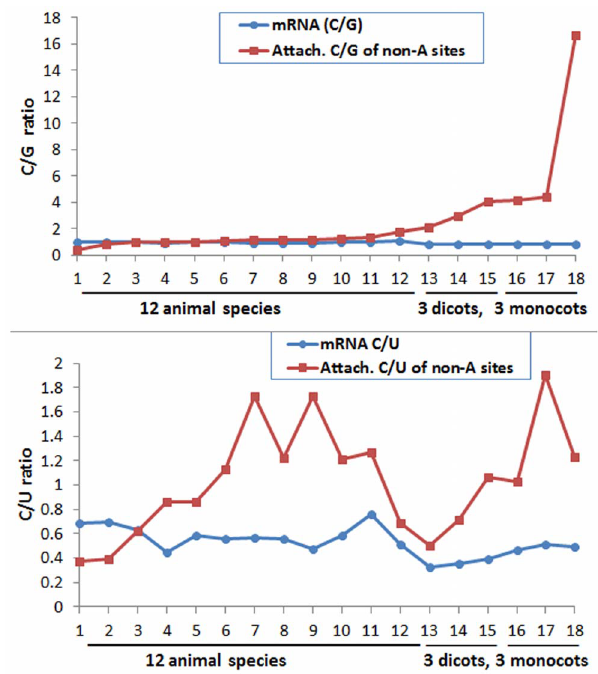
Figure 3. The C/G and C/U ratios at the polyadenylation [poly(A)] tail attachment position of non-A-type poly(A) transcripts. The 18 species, namely 12 animals, 3 dicot plants, and 3 monocot plants (3 cereals: rice, maize, and sorghum), were sorted from smallest (1) to largest (18) by the C/G ratios at the poly(A) tail attachment position of non-A-type poly(A) sites. The order of animal species from 1 to 12 is dog, rabbit, rat, zebrafish, mouse, cattle, zebra finch, orangutan, chicken, human, pig, and fruit fly. The three dicot plants are, in order, Medicago truncatula , Arabidopsis thaliana , and poplar. The three monocot plants are, in order, rice, maize, and sorghum. A: Comparison between the poly(A) tail attachment position C/G ratio and the messenger RNA (mRNA) C/G ratio. The mRNA C/G ratio is from the 99–nucleotide upstream region starting from, but not included, the poly(A) tail attachment position. There was an overall negative correlation between the poly(A) tail attachment nucleotide C/ G ratio and the mRNA C/G ratio ( r = 2 0.53, P , 0.05). Note that in animals, the poly(A) tail attachment position C/G ratio (1.05 on average) on non-A-type poly(A) sites was only slightly (1.08 times) greater than the mRNA C/G ratio (0.97 on average). In plants, however, the poly(A) tail attachment nucleotide C/G ratio (5.73 on average) was about sevenfold higher than the mRNA C/G ratio (0.83 on average), suggesting that plants strongly selected C over G as the poly(A) tail attachment nucleotide. B: Comparison between the poly(A) tail attachment position C/U ratio of non-A-type poly(A) sites and the messenger RNA (mRNA) C/U ratio. The 18 species were sorted from smallest ( # 1) to largest ( # 18) by the C/G ratios at the poly(A) tail attachment position of non-A-type poly(A) sites, as in the top panel. Note that the C/U ratio of the poly(A) tail attachment position of non-A- type poly(A) sites was greater than the messenger RNA C/U ratio in most species and the results suggest a selection of C over U at the poly(A) tail attachment position. doi:10.1371/journal.pone.0079511.g003 plants ( Table 3 ). Plants had lower adenosine content than animals did in this mRNA region. There was no significant correlation ( r =0.09) between the mRNA adenosine content and the adenosine percentage at the cleavage nucleotide replaced by the poly(A) tail ( Table 3 ). These results demonstrate that poly(A) site selection is not a simple, random reflection of the genomic nucleotide composition.